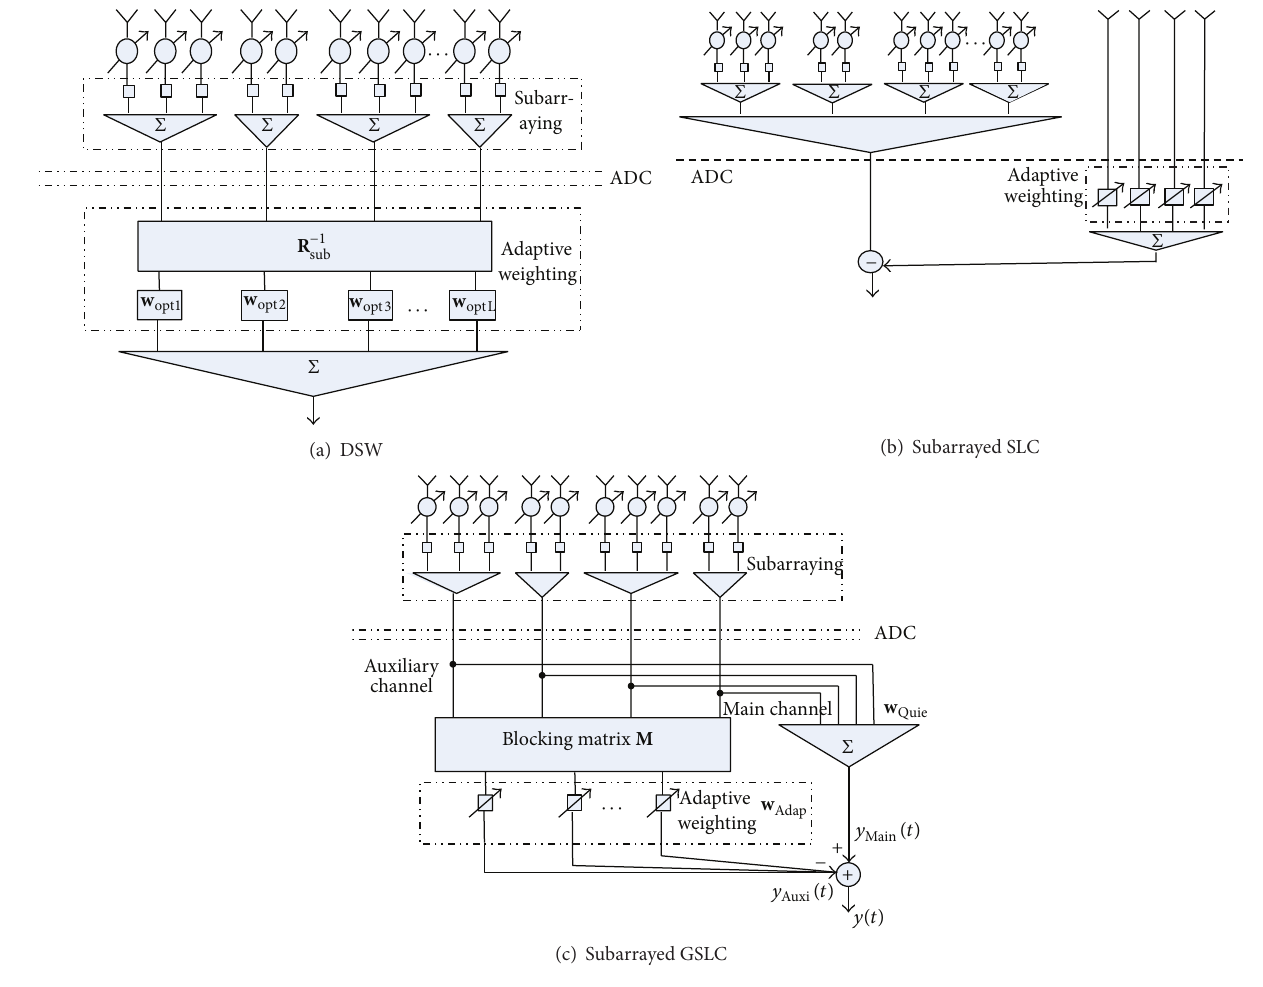
Figure 1: Configurations of subarrayed